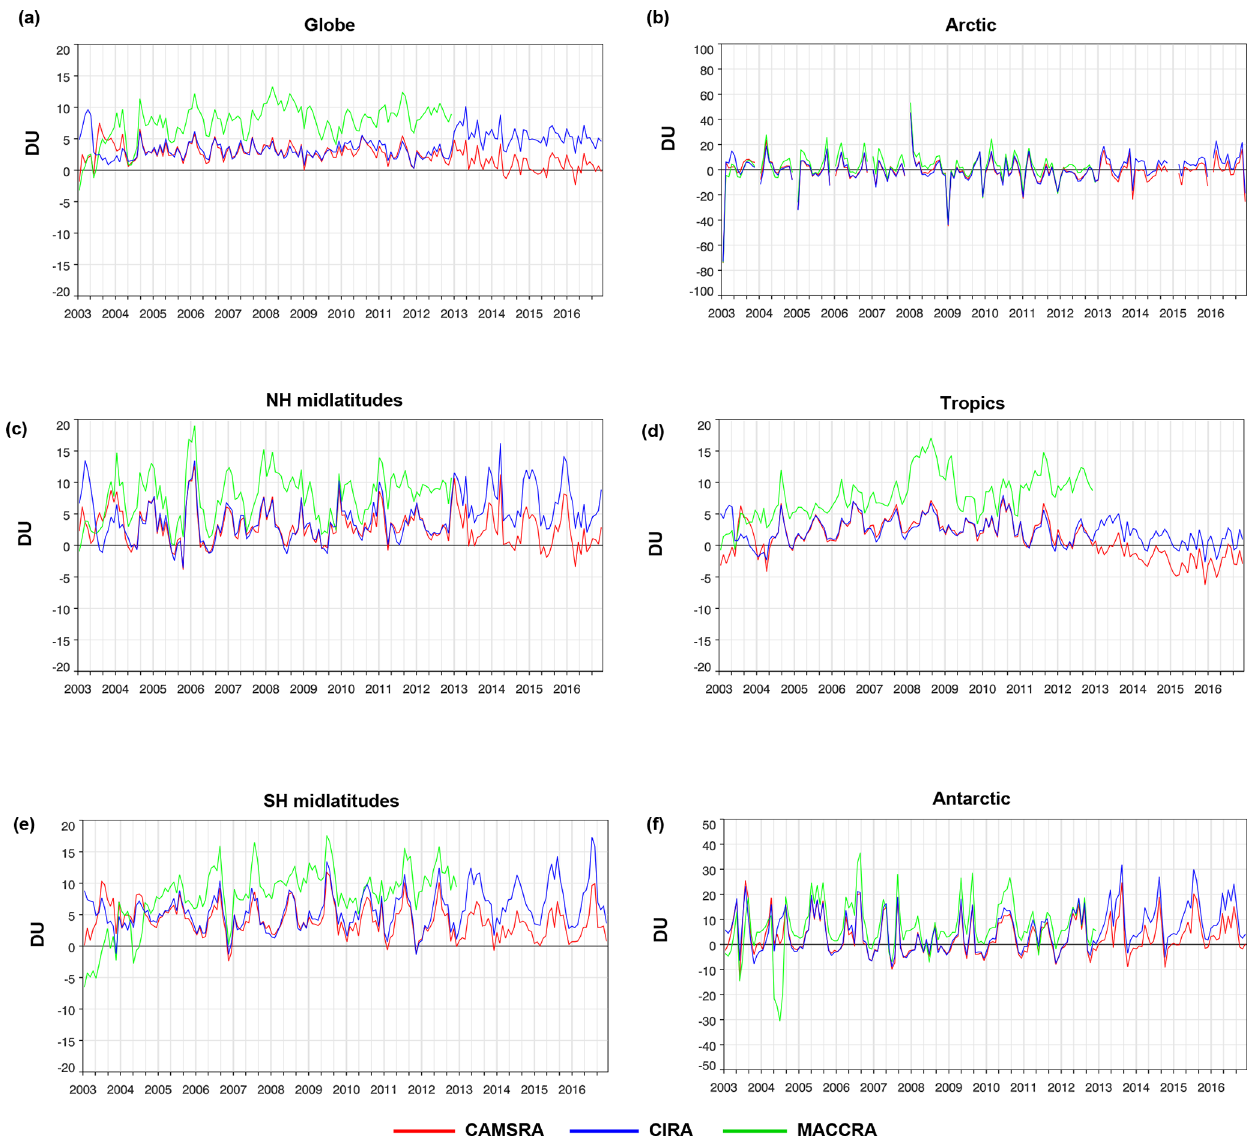
Figure 8. Time series of monthly mean TCO3 bias in DU from the three reanalyses compared to WOUDC Dobson data for the areas (a) globe, (b) Arctic, (c) NH midlatitude, (d) tropics, (e) SH and (f) Antarctic. About 50–60 stations were available from 2003 to 2014, dropping to about 40 stations after 2014. CAMSRA is shown in red, CIRA in blue and MACCRA in